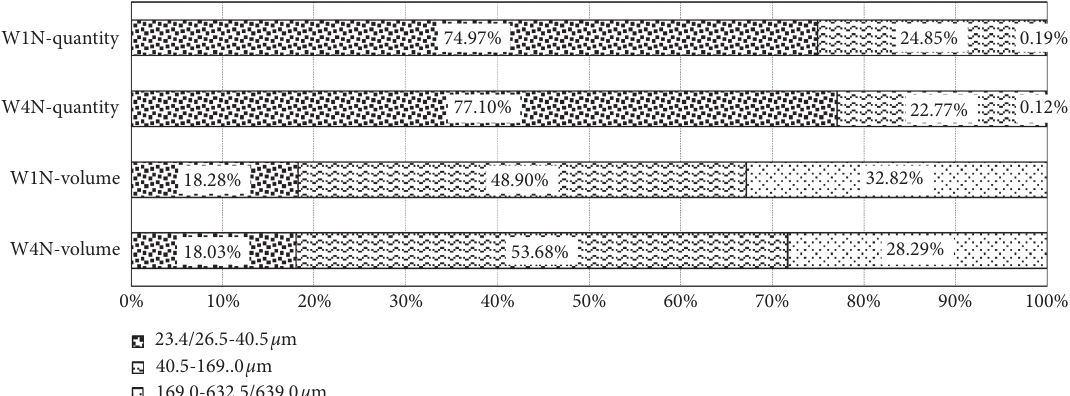
Figure 23: Quantity and volume proportion in different pore equivalent-diameter ranges of NCG concretion by 3D-XRM.